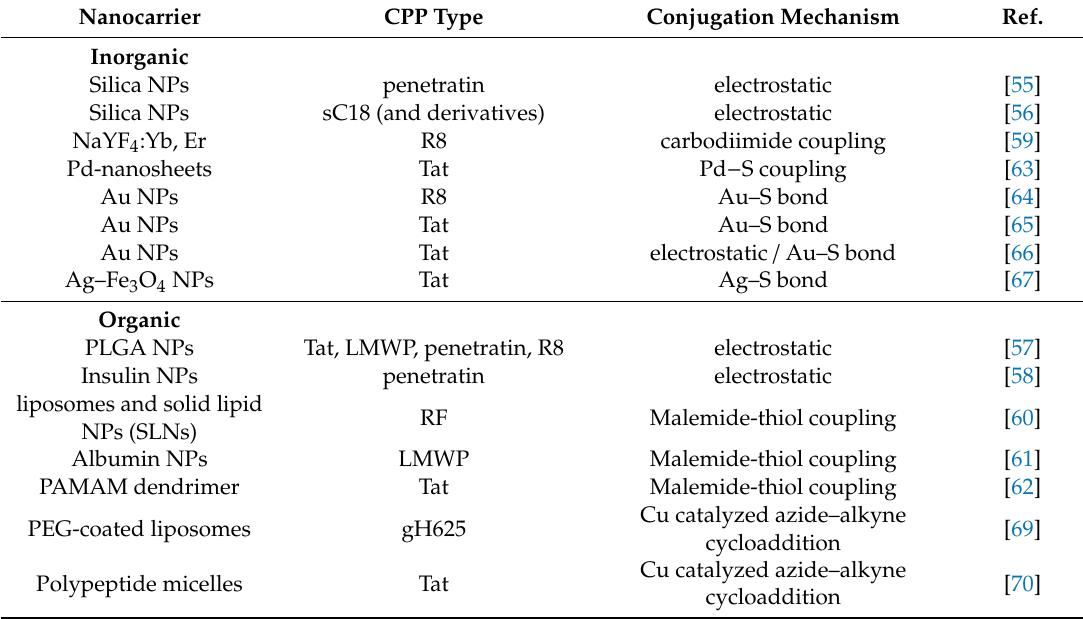
Table 2. Overview of NP-CPP conjugates and employed conjugation